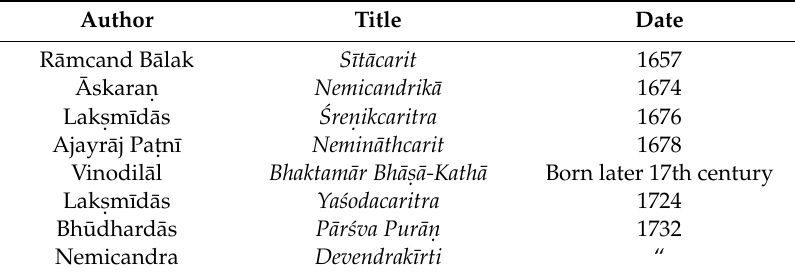
Table 2. Early Jain authors of narratives in Brajbh¯as. ¯a. 17